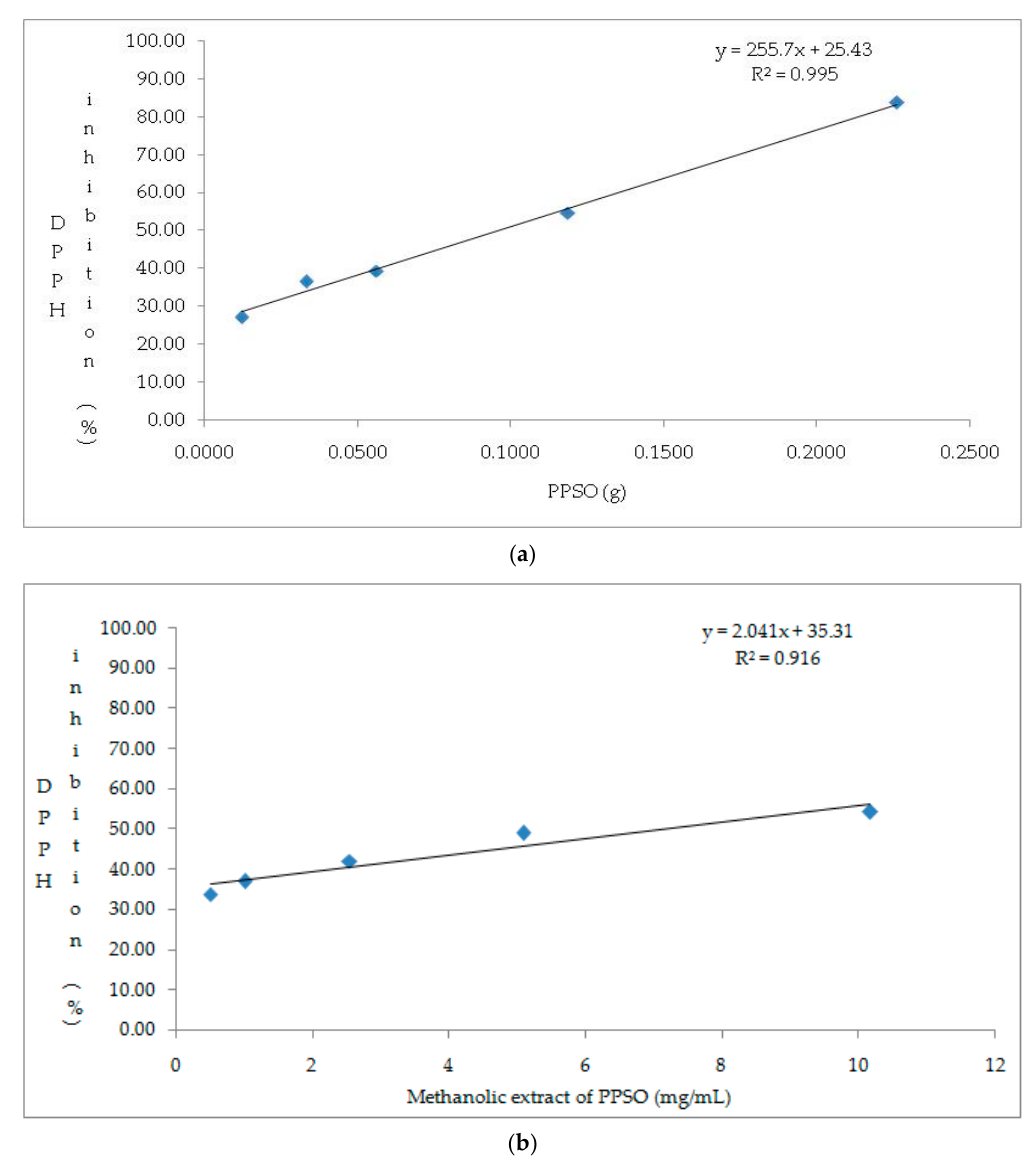
Figure 4. ( a ) 2,2-Diphenyl-1-picrylhydrazyl (DPPH) inhibition (%) of pure PPSO of di ff erent mass (g); Figure 4. ( a )2,2 ‐ Diphenyl ‐ 1 ‐ picrylhydrazyl (DPPH) inhibition (%) of pure PPSO of different mass (g); ( b ) DPPH inhibition (%) of methanolic extract of PPSO of di ff erent concentration (mg / ( b ) DPPH inhibition (%) of methanolic extract of PPSO of different concentration (mg/mL).